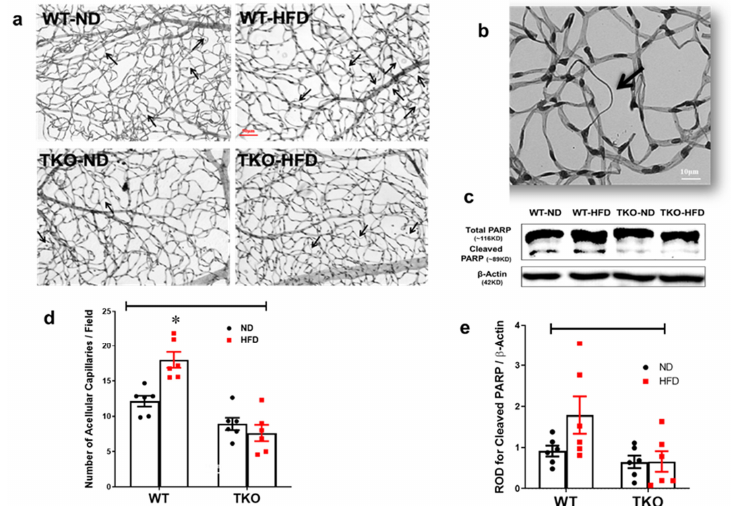
Figure 8. Deletion of TXNIP abrogates HFD-induced retinal microvascular degeneration. ( a ) Representative pictures of degenerated acellular capillaries from each of the groups, ( b ) magnification of a degenerated acellular capillary showing loss of endothelial cell nucleus and the remaining thickened basement membrane and ( c ) quantification of the number of acellular capillaries per field showed significantly higher numbers in the WT-HFD group compared with WT-ND. Two-way ANOVA showed significant interaction between the type of diet and genotype across microvascular degeneration ( n = 6 mice/group; * p < 0.05 vs. all groups). ( d ) Representative WB blots and ( e ) statistical analyses of cleaved PARP showed a trend towards increased expression in the WT-HFD group compared with the WT-ND control group. Two-way ANOVA showed significant interaction between genotype (TKO vs. WT) ( n = 8 mice/group). Int. J. Mol. Sci. 2020 , 21 , x FOR PEER REVIEW